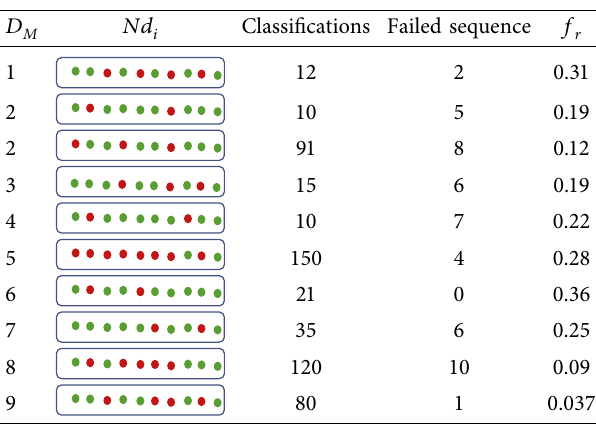
Table 1: Modification to f